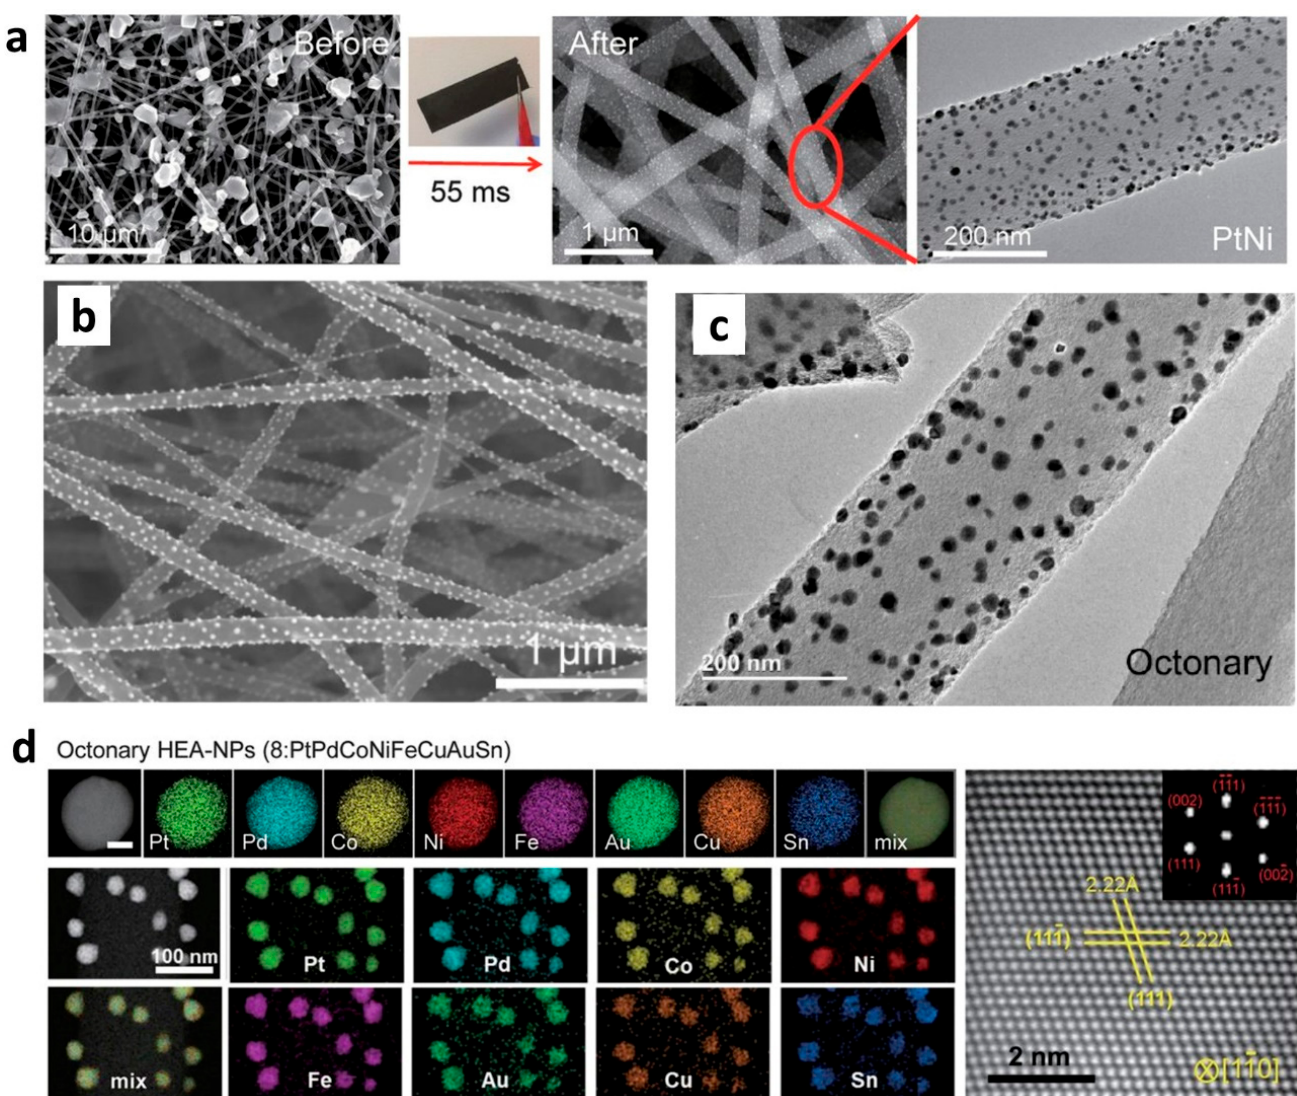
Figure 2. Nanoparticles loading onto carbon nanofibers derived from electrospun PAN nanofibers. ( a ) Illustration of carbothermal shock (CTS) method after electrospinning to synthesize high-entropy-alloy nanoparticles (HEA-NPs): SEM images of microsized precursor salt particles before and after CTS. ( b – d ) SEM, TEM, and HAADF-STEM mapping images of octonary alloy nanoparticles. Reprinted and adapted with permission from ref. [65]; Copyright 2018, AAAS.